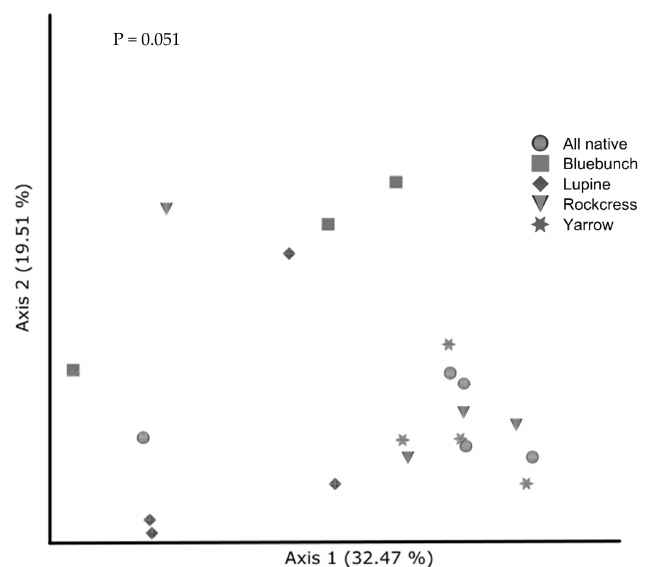
Figure 5. Principal coordinates analysis of fungal communities from native study cover crops visualized by Weighted UniFrac distance. Treatments are all species together (“All native”), bluebunch wheatgrass (“Bluebunch”), Silky lupine (“Lupine”), Holboell’s rockcress (“Rockcress”), and white yarrow (“Yarrow”). Fungal communities show no significant clustering overall ( p = 0.051); however, bluebunch wheatgrass (squares) and white yarrow (stars) reveal differences in beta diversity ( p = 0.036, q = 0.280). In the cultivar study, cover crop diversity changed community composition only in some treatments (Figure 6). All cultivar communities were distinct from fallow ( p = 0.005) and wheatgrass ( p = 0.017) but not others. Overall dispersion of fungal communities from monocultures was similar ( p = 0.183).